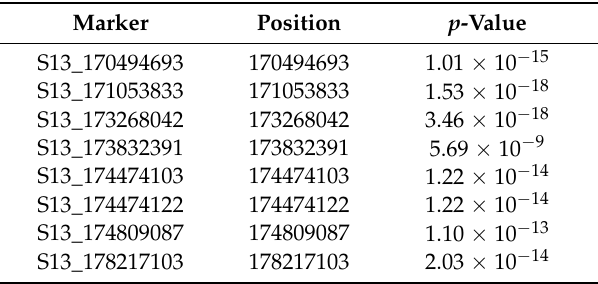
Table 1. List of Single nucleotide polymorphisms at linkage group 13, significantly associated with the ability to suppress CMS phenotype after Bonferroni correction. Marker